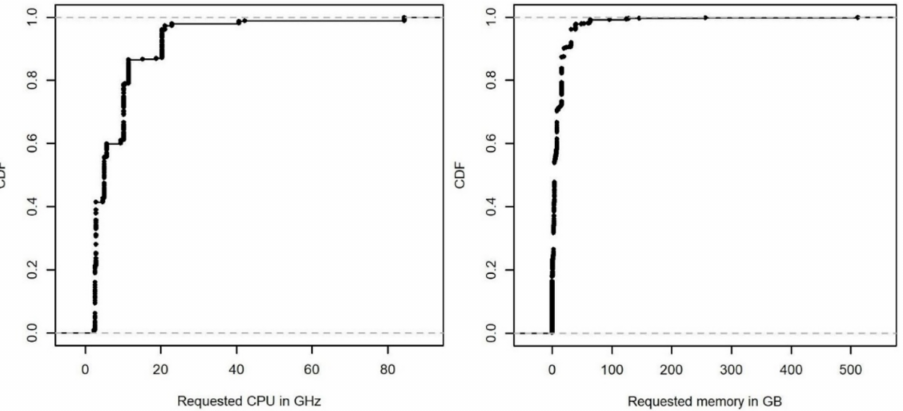
Figure 2. CDFs of the requested CPU frequency ( left ) and the amount of requested RAM ( right ). Newly created VMs do not request the amount of storage performance and the net- work interface throughput during simulation. Thus, the initial VM-to-PM assignment (initial VM placement) is performed according to the amount of CPU and memory re- quested per VM, as presented in